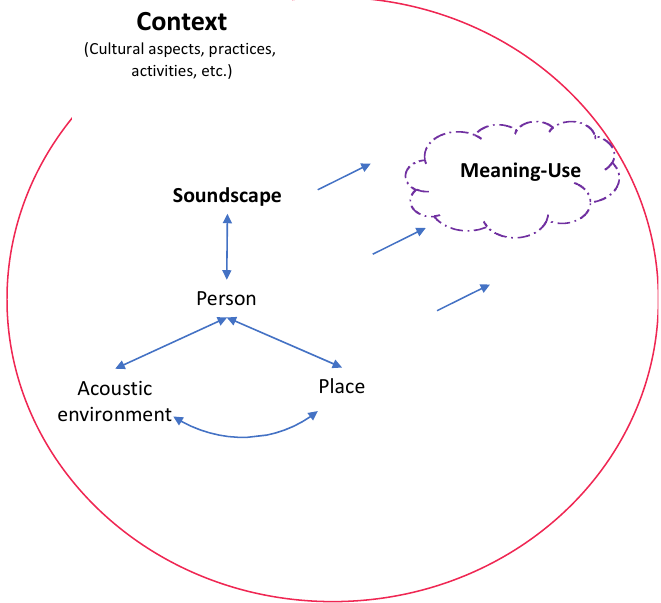
Figure 8. Semiosis model for urban soundscapes.